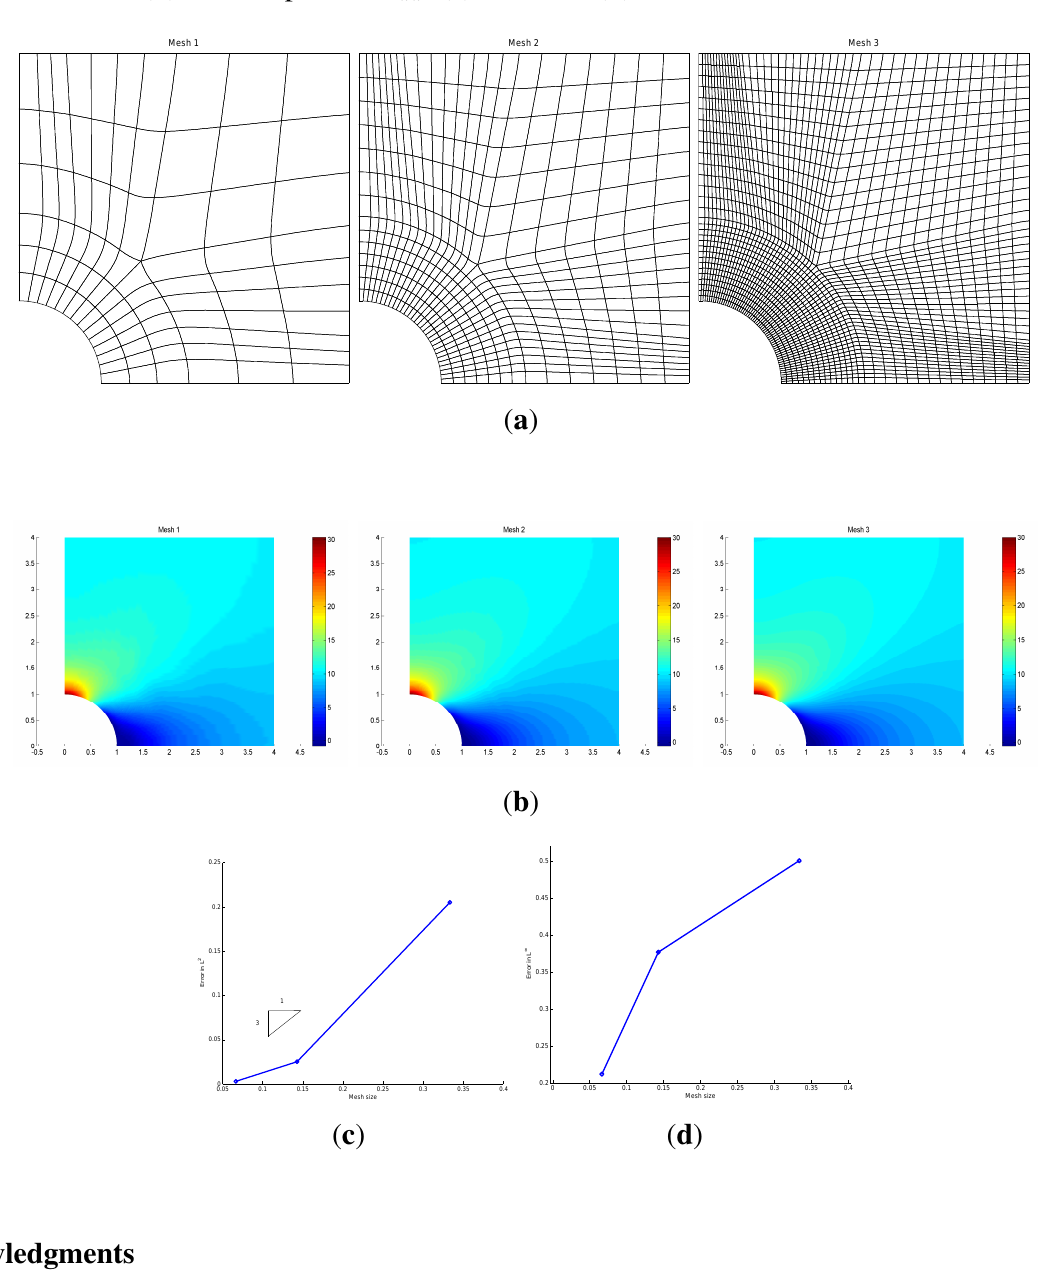
Figure 13. The G 1 bi-3/bi-5elements on the elastic plate with a circular hole. ( a ) h -refinement; ( b ) contour plots of σ ; ( c ) L 2 -error; ( d ) L ∞ -error. xx Mesh 1 Mesh 2 Mesh